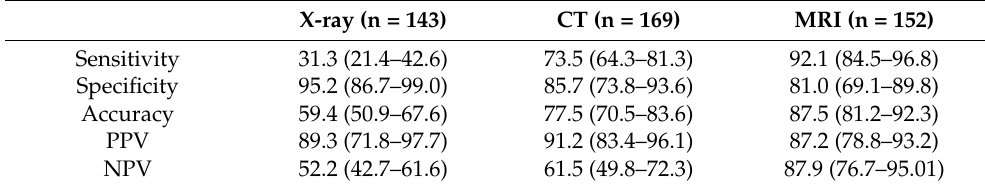
Table 2. Sensitivity, specificity, accuracy, positive and negative predictive values (PPV, NPV) estimates of imaging techniques for detection of focal skeletal